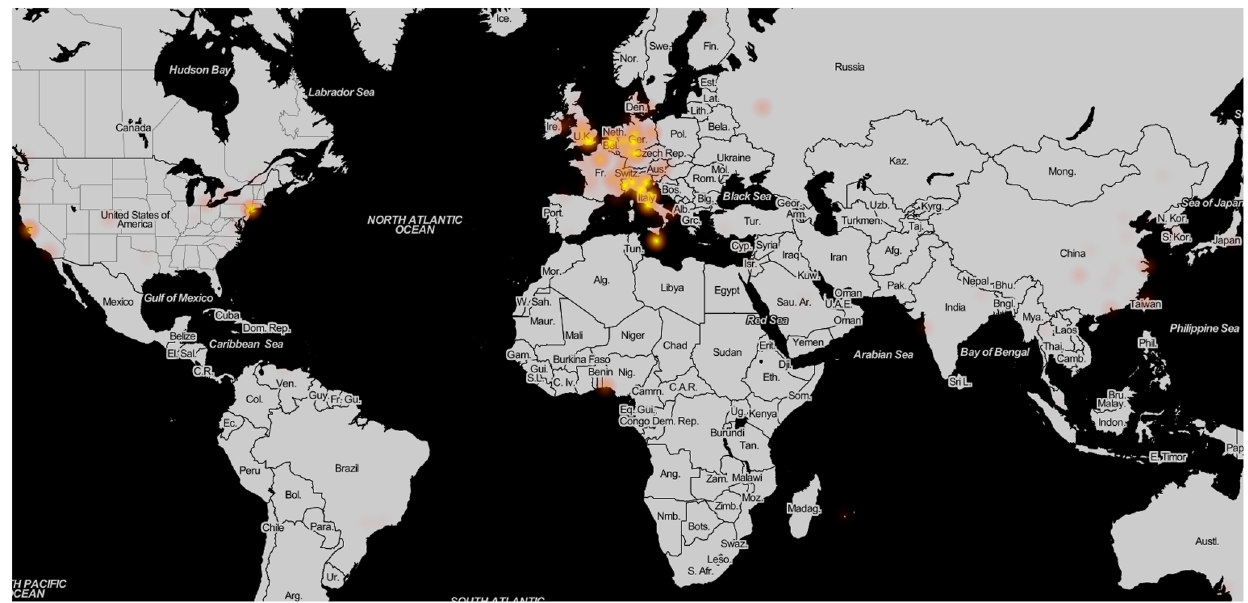
Figure 10. Tag heatmap. Worldwide sample density, including only measurements with attached tags, illustrated as a heatmap ( (cid:2) OpenStreetMap contributors for map data, used and redistributed under the CC-BY-SA